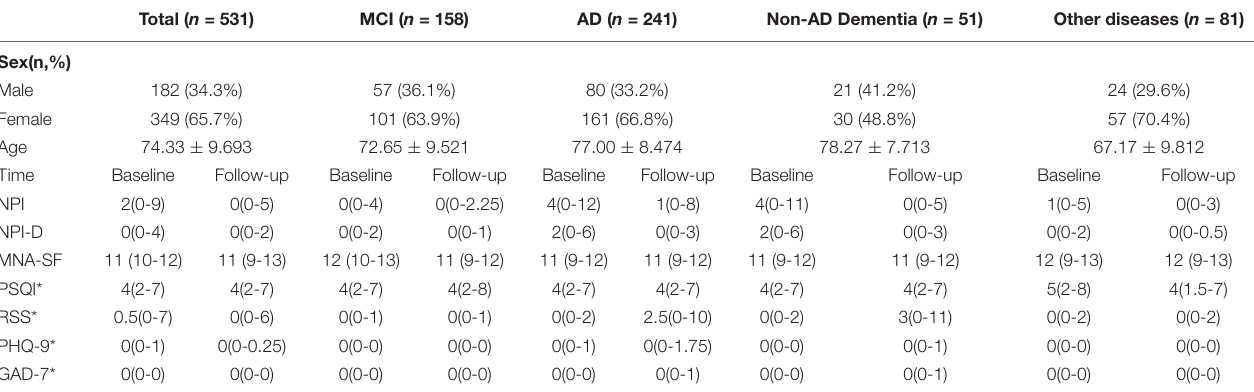
TABLE 1 | Demographic and general evaluative outcomes of participants enrolled in the cohort study.